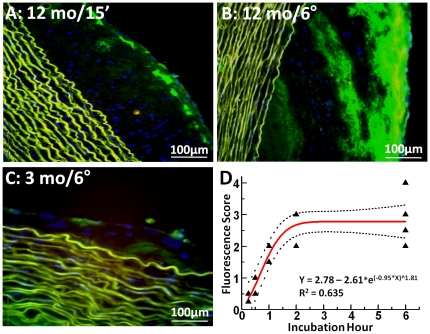
Fluorescence microscopy of rabbit aorta segments after ex vivo NP incubation for different times.A, B: 12 month cholesterol diet rabbit incubated with Alexa Fluor 488-labeled NP (green) for 15 minutes and 6 hours, showing progressively deeper penetration into intimal plaque region. Media shows elastin autofluorescence (yellow-green) only. Blue = nuclear stain C: 3 month cholesterol diet rabbit aorta incubated for 6 hours with Alexa Fluor 488-labeled NP showing minimal plaque thickening and only minor particle accumulation at endothelial surface. D: “Fluorescence score” of ex vivo NP-treated 12-month diet rabbit aorta segments incubated for different times, confirming greater penetration with longer NP exposure times. The exponential fit to the data indicates an asymptotic increase in penetration with little additional diffusion beyond 2 hour incubations.